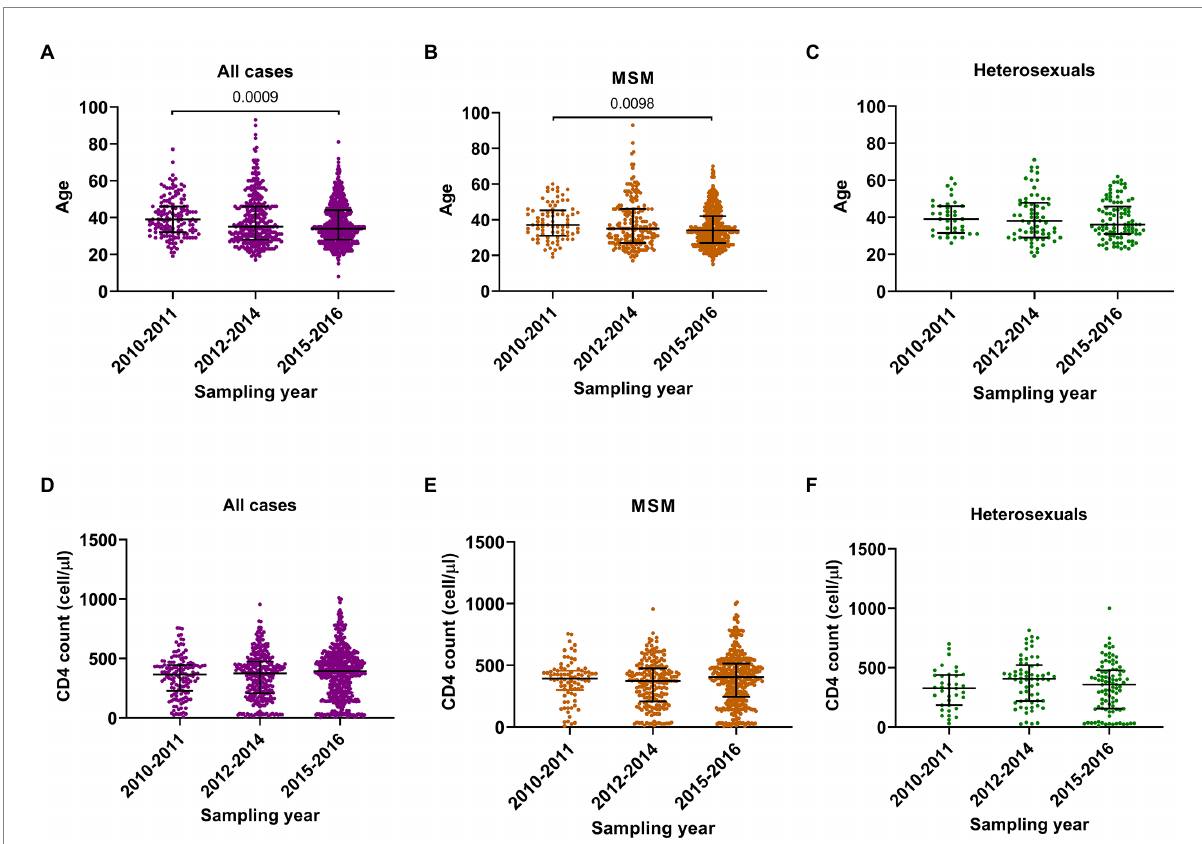
FIGURE 1 Comparison analyses on ages and CD4 cell counts in three sampling times. (A–C) The age in all participants, men who have sex with men (MSM) and heterosexuals. (D–F) The CD4 cell count in all participants, MSM and heterosexuals. Data were shown as median with interquartile range. Comparison across groups was done by Kruskal–Wallis